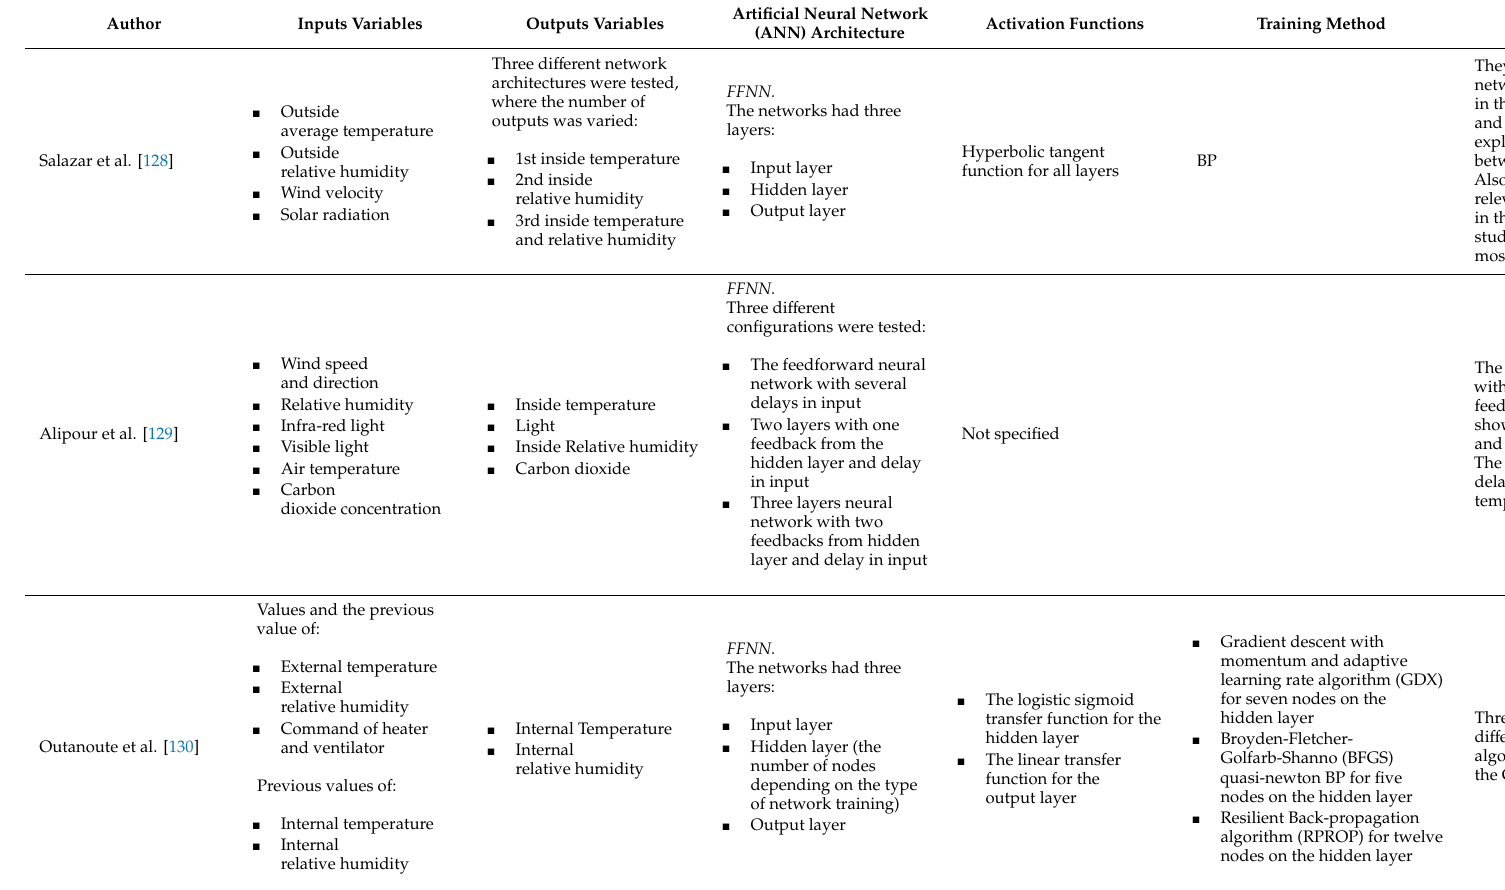
They report that the third network obtained better results